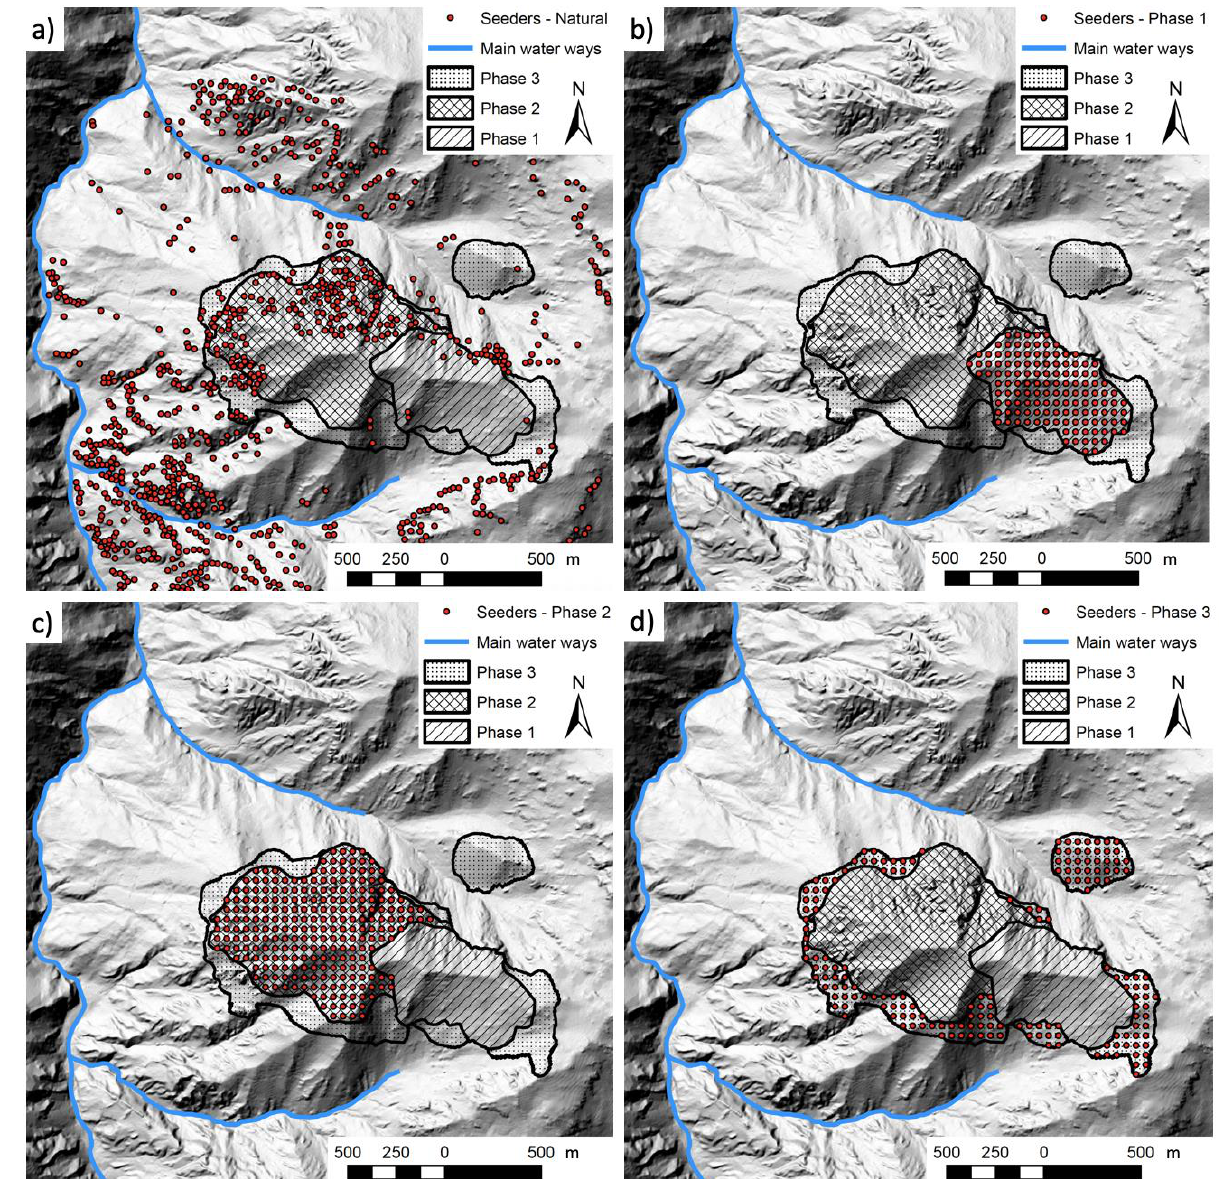
Figure 7. Rockfall trajectory model seeder locations for naturally occurring rockfalls (pre-mining) ( a ), and phases 1 ( b ), 2 ( c ) and 3 ( d ).